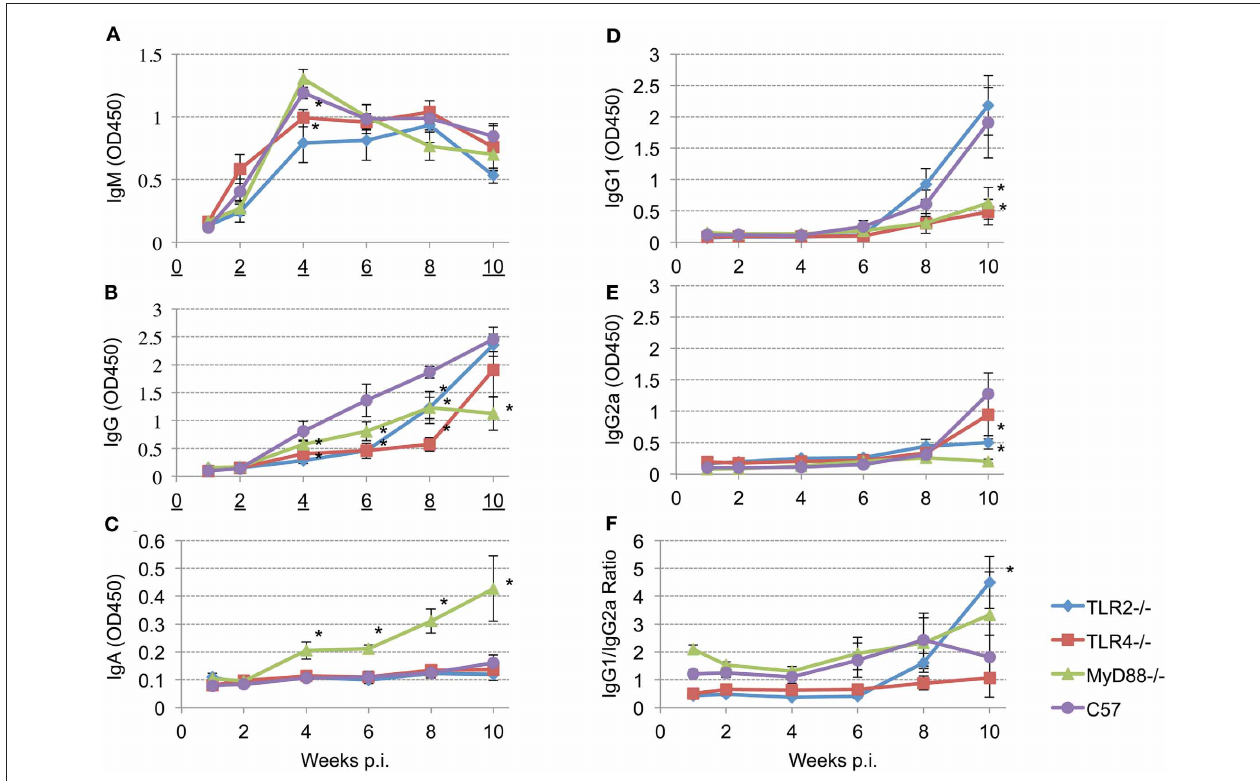
FIGURE 5 | Different TLRs play different roles in eliciting antibody responses after aerosol challenge. Groups of TLR2 − / − , TLR4 − / − , MyD88 − / − and C57BL/6 mice were aerosol exposed to B. melitensis 16M. Blood samples were collected at 1, 2, 4, 6, 8, and 10 weeks post infection